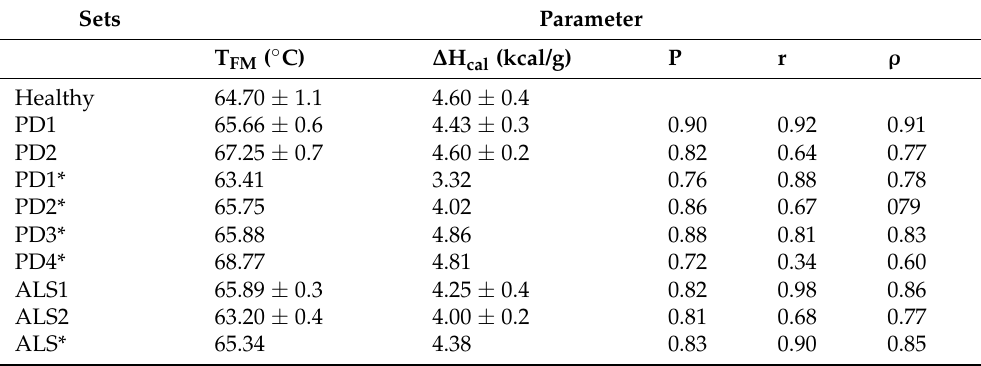
Table 2. Weighted average center of the thermograms (T FM ) and calorimetric enthalpy ( ∆ H cal ) of healthy, PD, and ALS calorimetric profiles (average values and SD for PD and ALS sets) and statistical parameters (spatial distance metric (P); Pearson‘s correlation coefficient (r) and similarity metric ( ρ )) for PD sets, PD1*–PD4* cases (not included in the PD sets), ALS sets, and ALS* case (not included in ALS sets) relative to the healthy